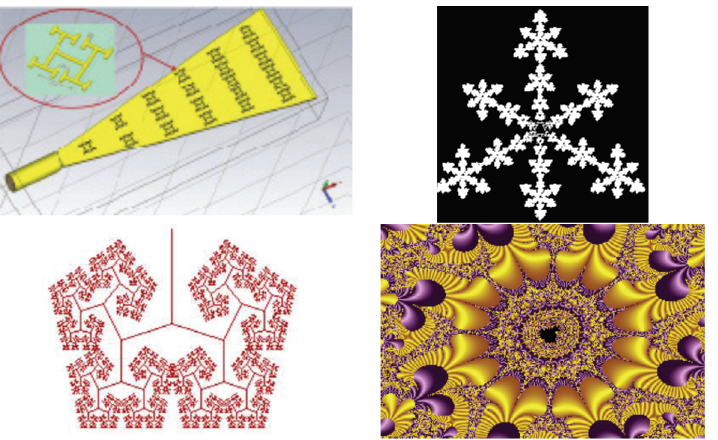
Figure 2. Essence and technique of fractal objects: the fractal cells printed with metamaterial in the GTEM chamber septum